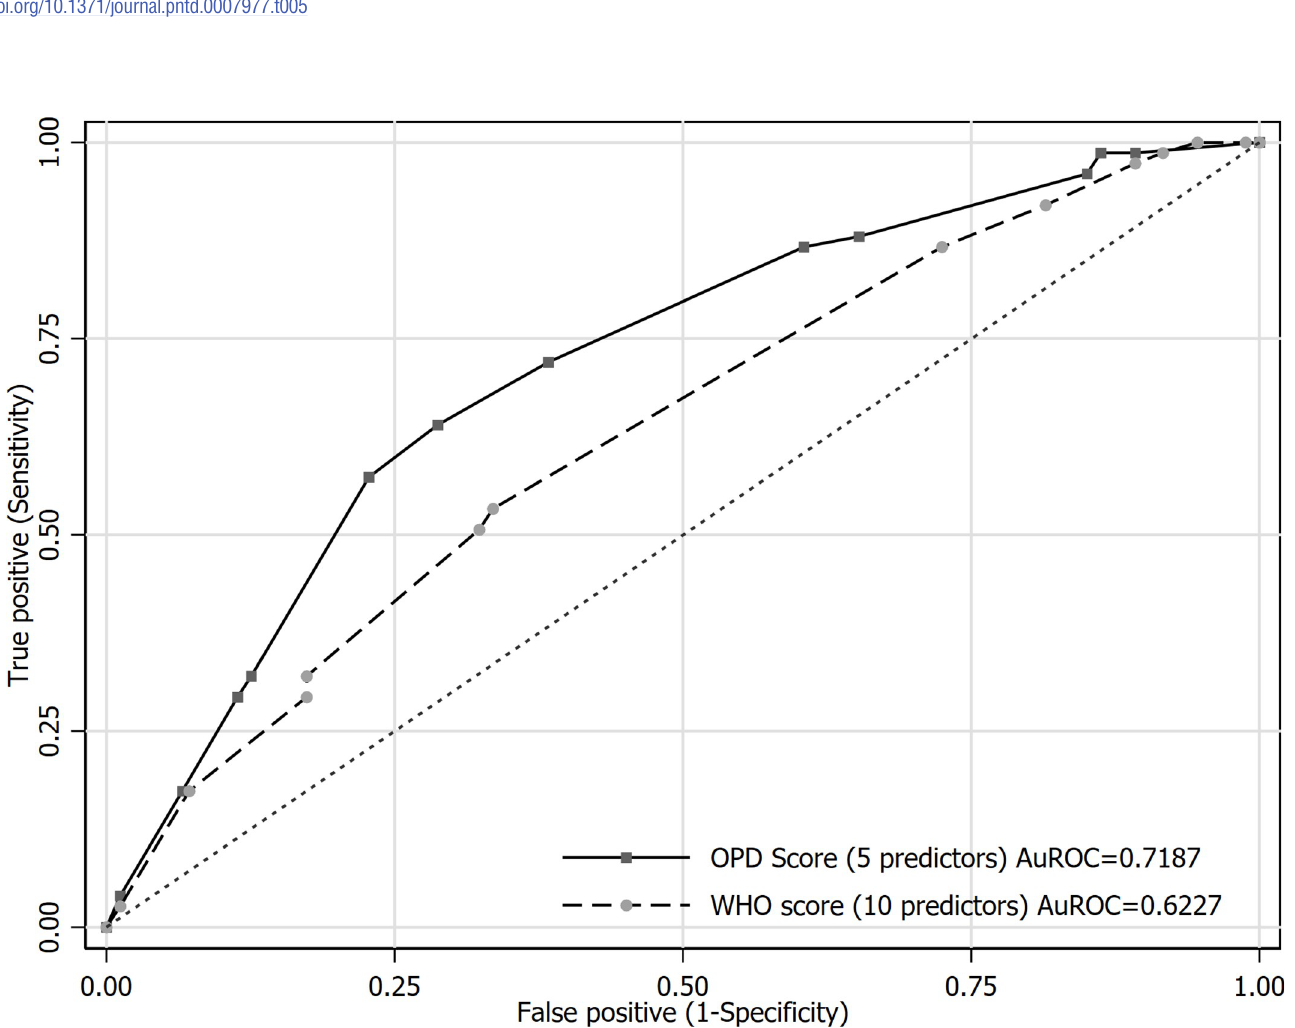
Fig 3. Receiver operating characteristic curve in diagnostic prediction of leptospirosis, comparison of OPD score and standard WHO score within development cohort.